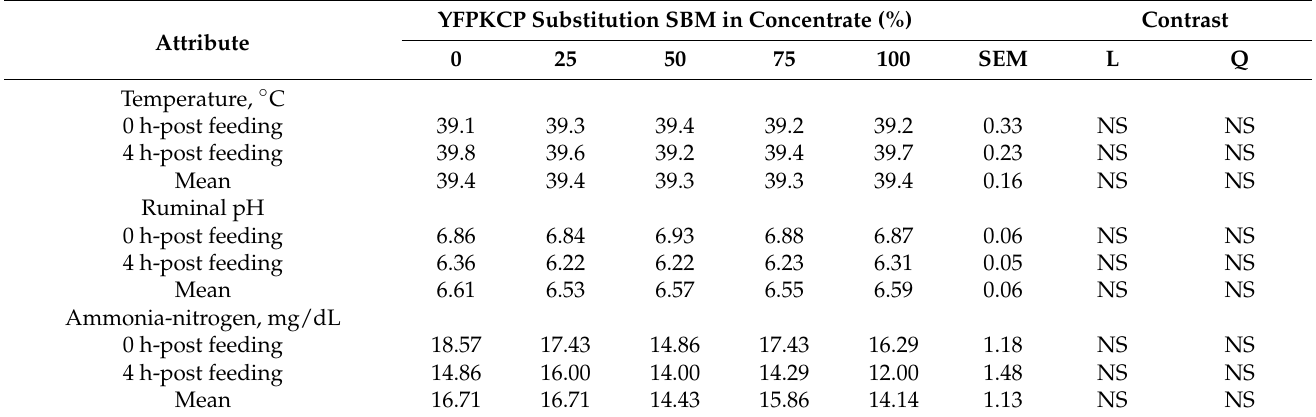
Table 4. Rumen fermentation parameters in goats fed various levels of fermented palm kernel cake.